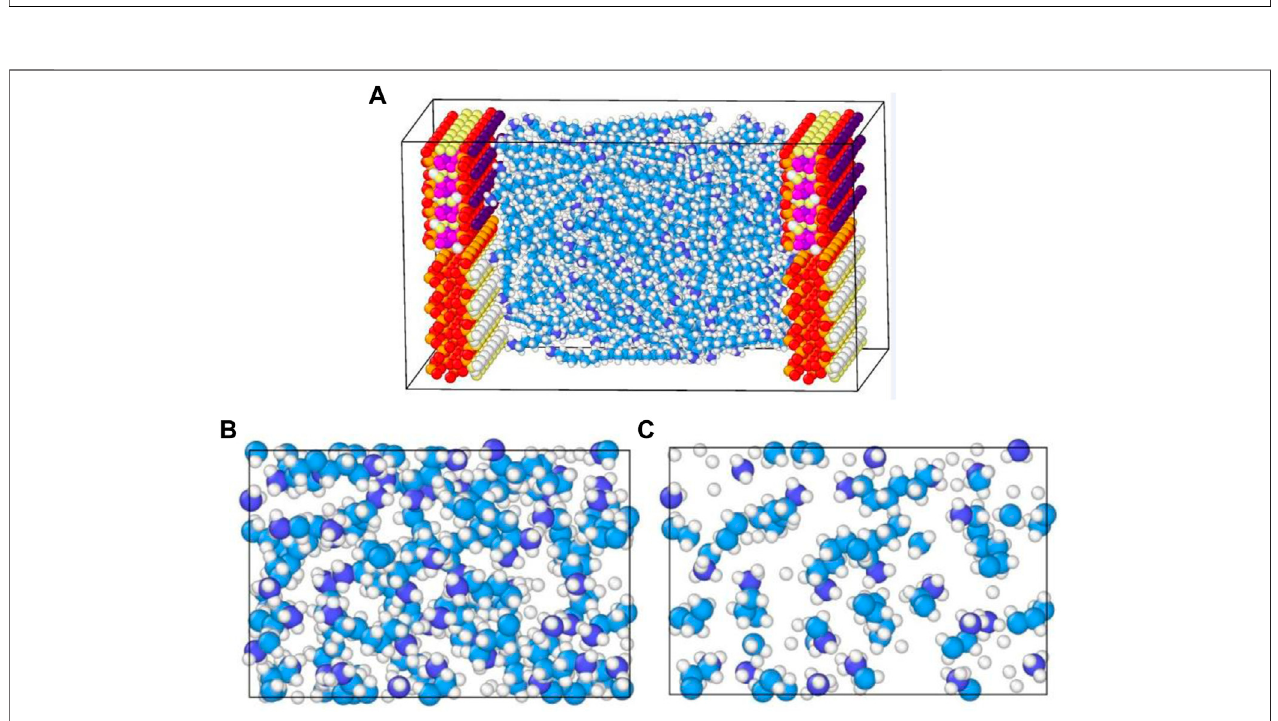
FIGURE 7 | (A) Equilibrium con fi gurations snapshots of nC19 in mixed nanopores; (B) Snapshot showing the fl uid distribution of nC19 in the near-wall region; (C) Snapshot showing the fl uid distribution of nC19 in a bulk region.